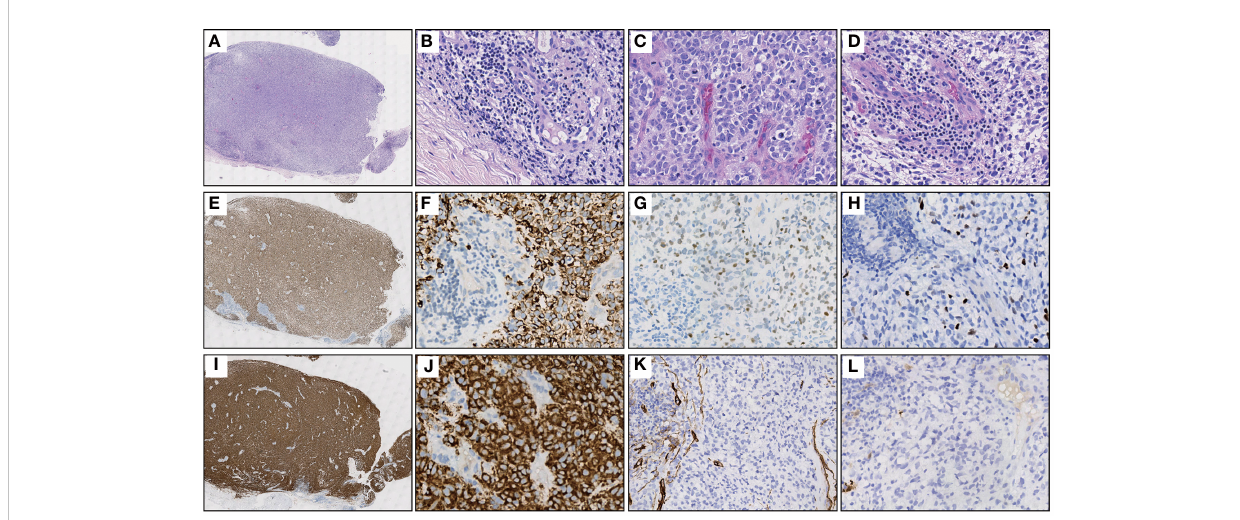
FIGURE 2 Representative H&E and IHC stainings of serial sections. (A) Extra-low power H&E image shows a well-demarcated mass entirely, surrounded by fi brous pseudocapsule. (B) High power view of A gets more detail about the pseudocapsule, simultaneously, demonstrates hyperendothelial vessels and lymphocytes that aggregated around these vessels. (C) The tumor is primarily composed of primitive round cells with scant cytoplasm and numerous mitosis. (D) Focally shows clear cytoplasm and lymphocytes aggregating around the hyperendothelial vessels. (E) Diffuse Desmin staining in the same power view of (A, F) A high power view of E showing cytoplasmic positive of Desmin, while the nonmuscular hyperendothelial vessels are negative for Desmin. (G, H) Focal positive immunohistochemical staining of tumor cells for MYOD1 and Myogenin respectively. (I, J) The immunohistochemical staining for TrkA/B/C expression was performed using pan-Trk (clone EPR17341, Roche/Ventana). There is a strong diffuse immunoreactivity for pan-Trk in cytoplasm of tumor cells. (K, L) Negative IHC reaction for CD34 and S100,